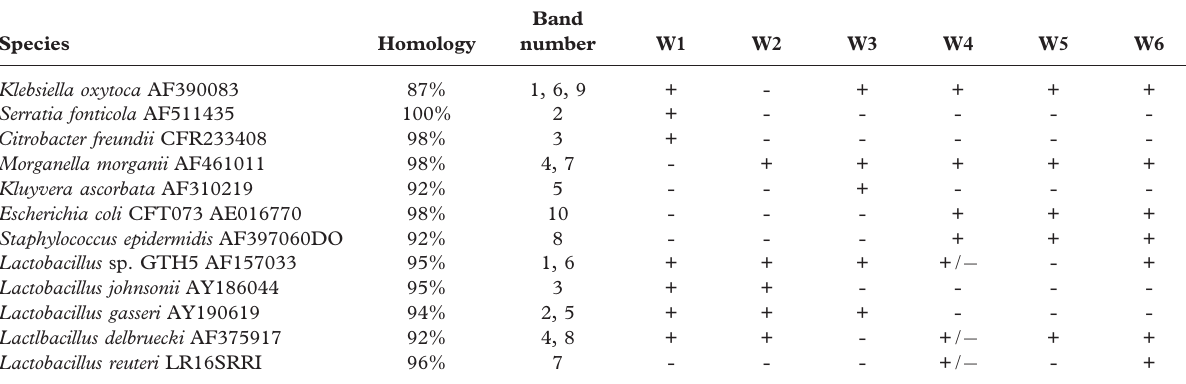
Table I. BLAST analysis of vaginal bacterial and lactobacilli 16SrRNA sequences of excised fragments from DGGE gels. +:band detected on the DGGE gel, -:band not detected on the DGGE gel, +/ 7 :weak signal on the DGGE gel.